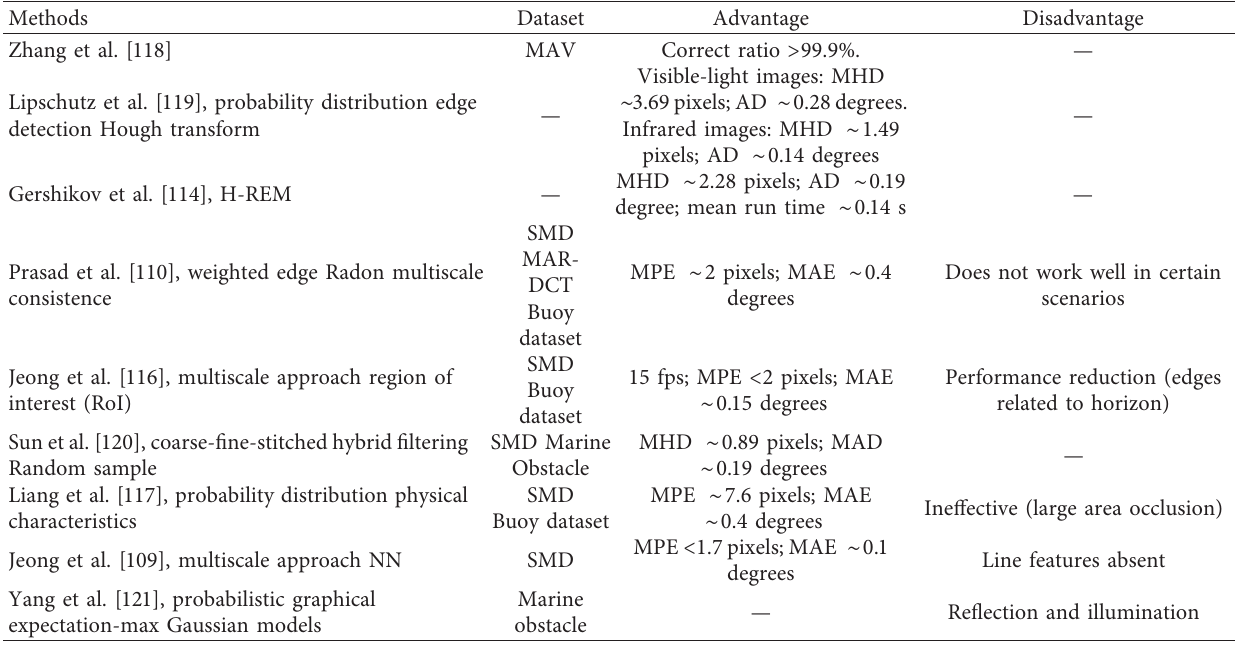
Table 1: Examples of typical marine horizon detection